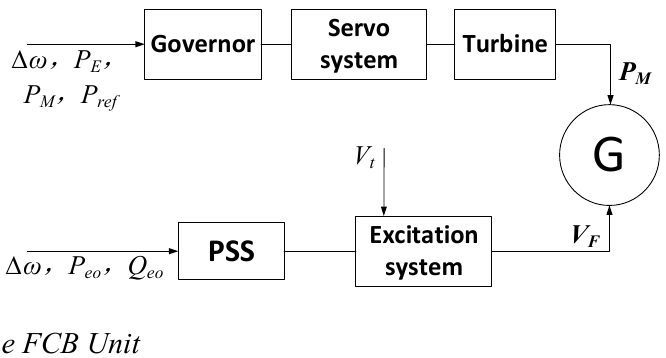
Figure 3. The whole structure of the fast cut back (FCB) unit dynamic model. PSS: power system stabilizer.